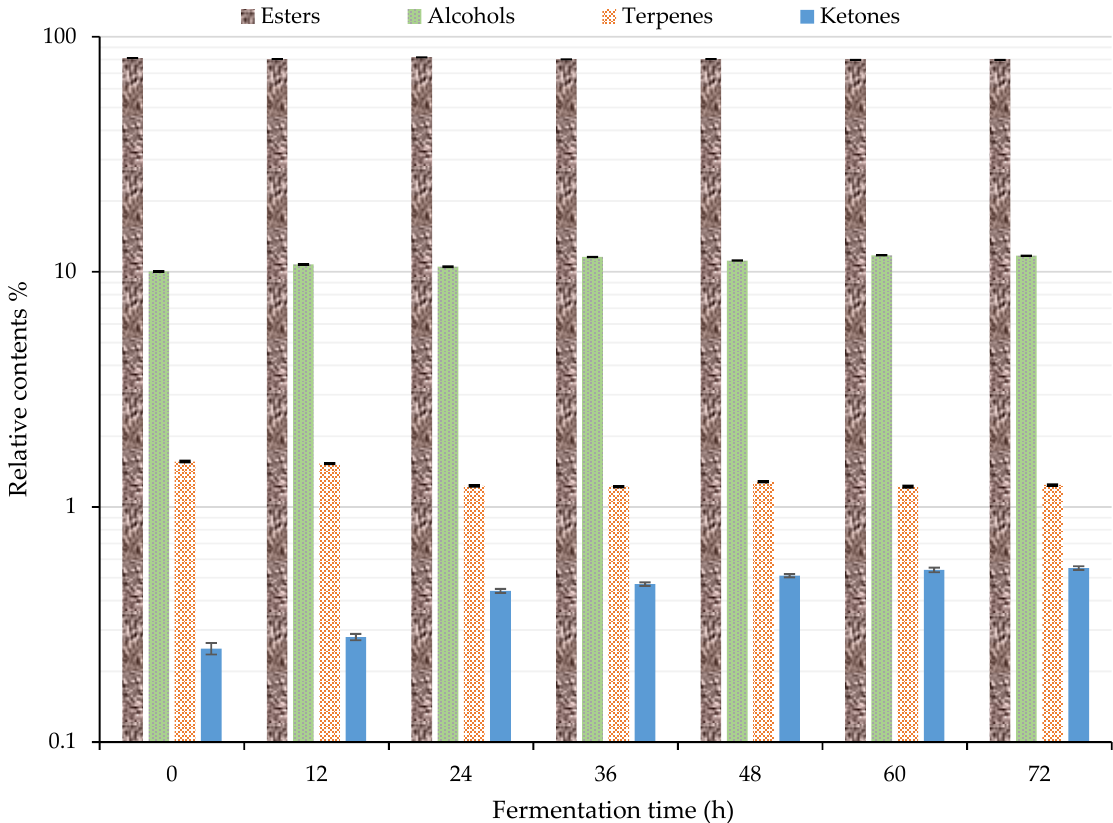
Figure 5. Changes of volatile flavor compounds during the fermentation of sea buckthorn juice by GC – IMS.